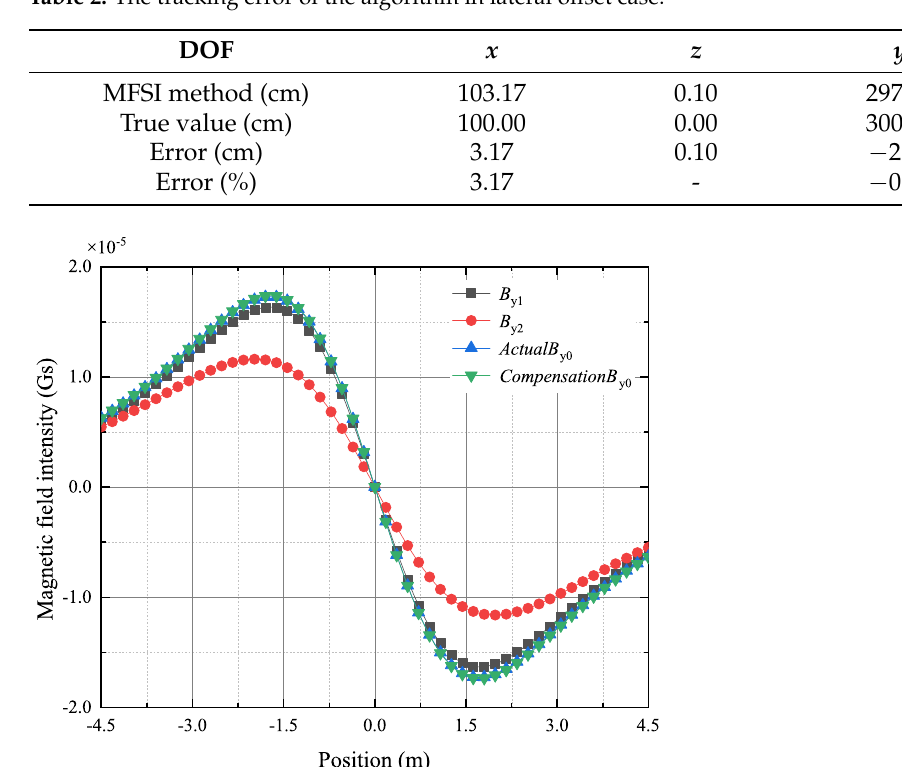
Table 2. The tracking error of the algorithm in lateral offset case.